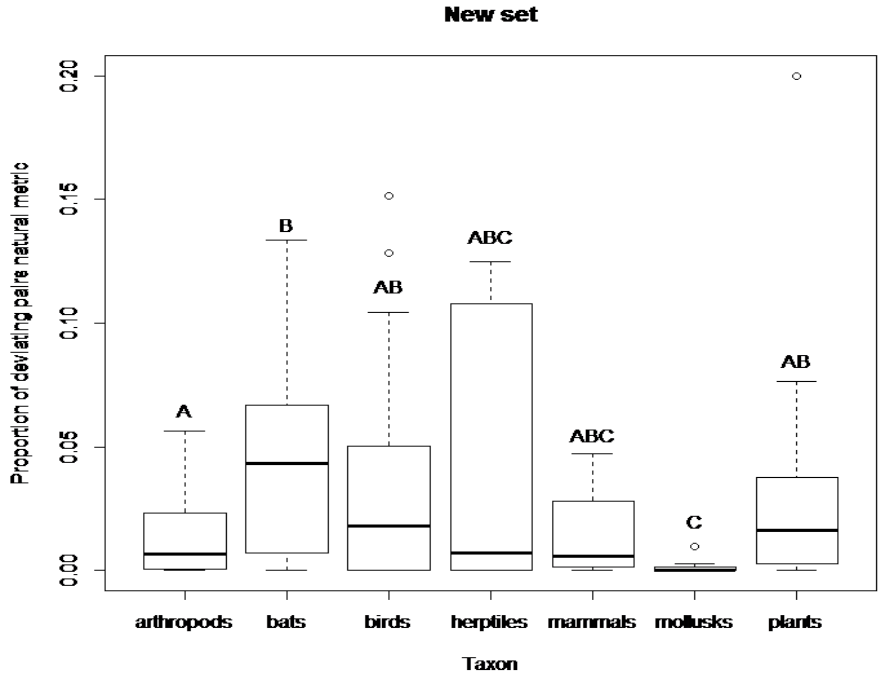
Figure 3. Boxplot showing the proportion of deviating pairs (natural metric) for each taxonomic group in the new set of published matrices. The thick line in each box represents the median of the sample. Circles represent sample outliers. Letters above plots indicate similarities among taxa (same letters stand for no statistical